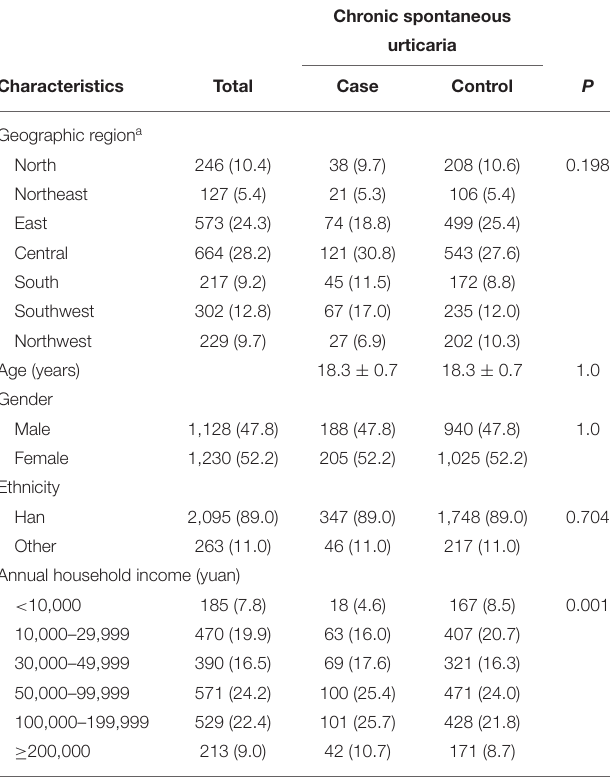
TABLE 1 | Characteristics of participants, stratified by chronic spontaneous